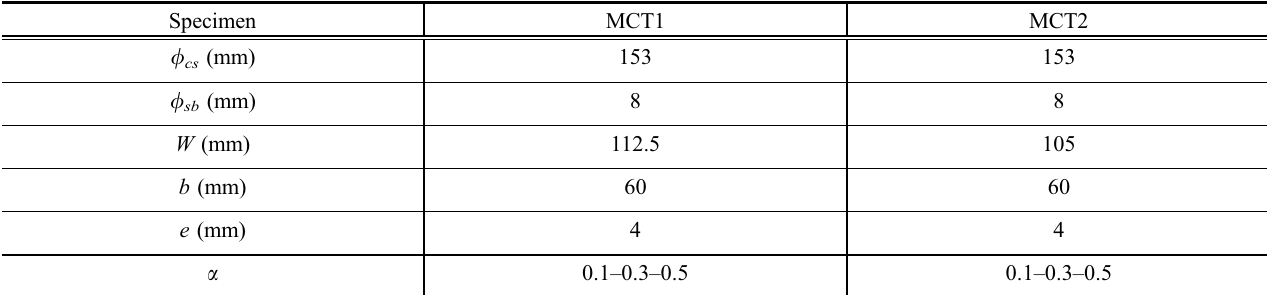
Table 3 Dimensions of the MDCT specimens tested in the experimental program.